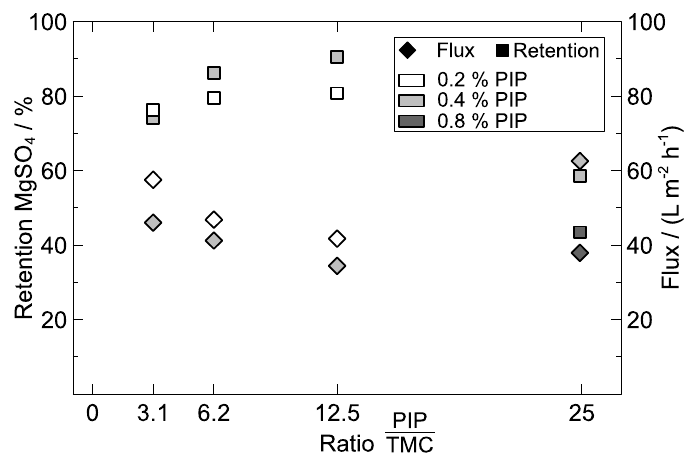
Figure 8. Effect of reactive monomer ratio (PIP/TMC) on the performance of composite MCM; concentration of TEA in the aqueous amine solution: 0.15 wt %; drying time: 15 min; feed solution: 3000 mg L − 1 MgSO 4 ; TMP = 2 bar.